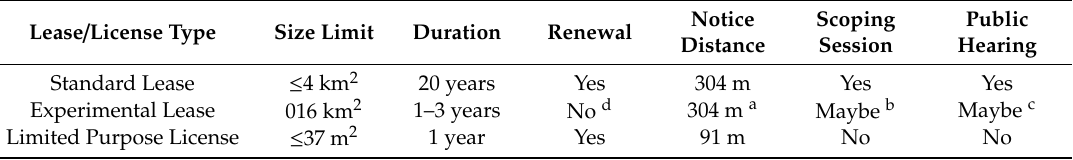
Table 1. Maine aquaculture lease and license characteristics